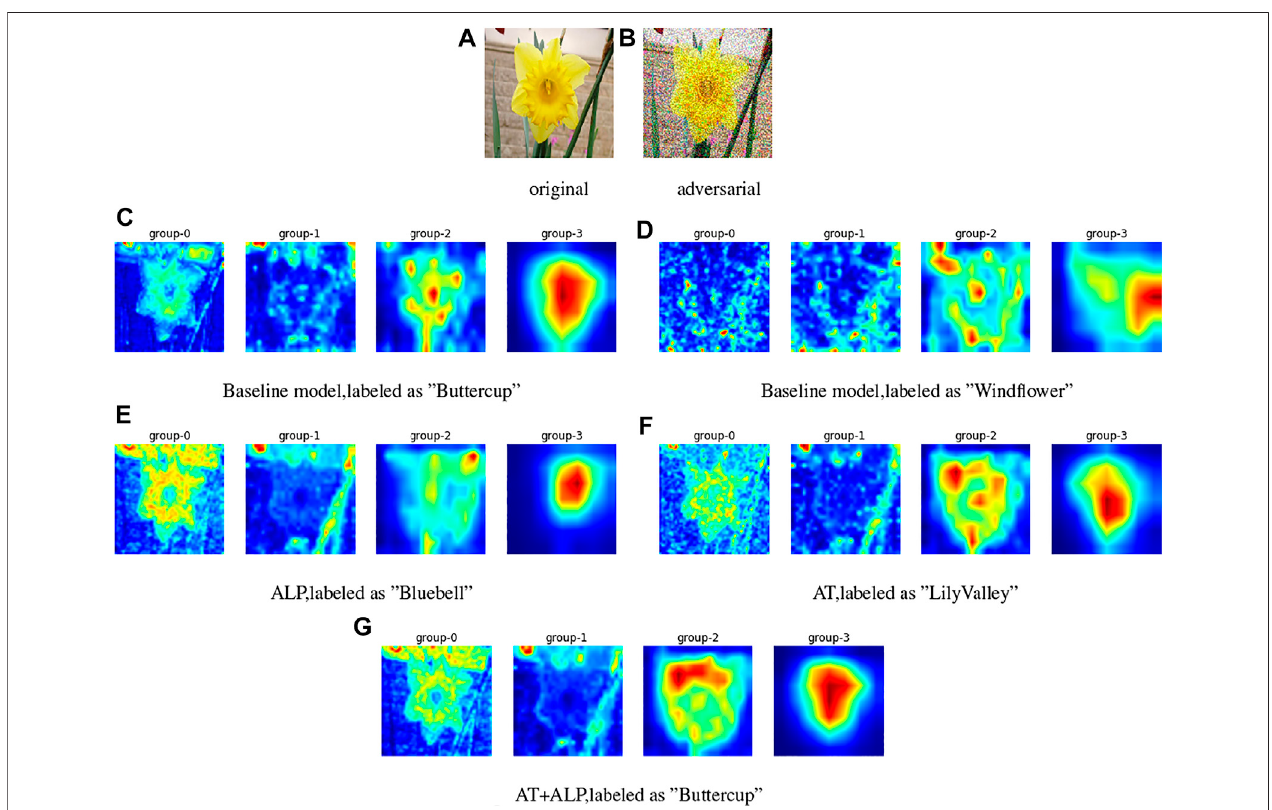
FIGURE 4 | Activation attention maps for defense against gray-box PGD attacks ( ϵ (cid:1) 0.25) on 17 Flower Category Database. (A) is original image and (B) is corresponding adversarial image. (C) and (D) are activation attention maps of baseline model for original image and adversarial image, (E,F,G) are activation attention maps of ALP , AT and AT + ALP for adversarial image. Group-0 to group-3 represent the activation attention maps of four groups of convolutional structures in the baseline model, group-0 extracts of low-level features, group-1 and group-2 extract of mid-level features, group-3 extracts of high-level features Zagoruyko and Komodakis (2016). It can be clearly found that group-0 of AT + ALP can extract the outline and texture of fl owers more accurately, and group-3 has a higher level of activation on the whole fl ower, compared with other defense methods, only it makes accurate